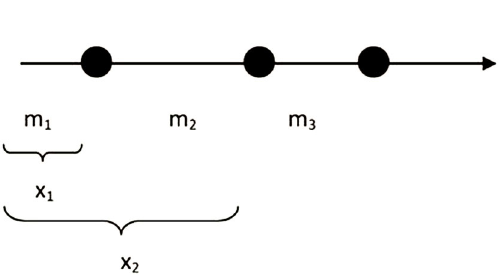
FIG. 9. Discrete center-of-mass diagram used in lesson 6.